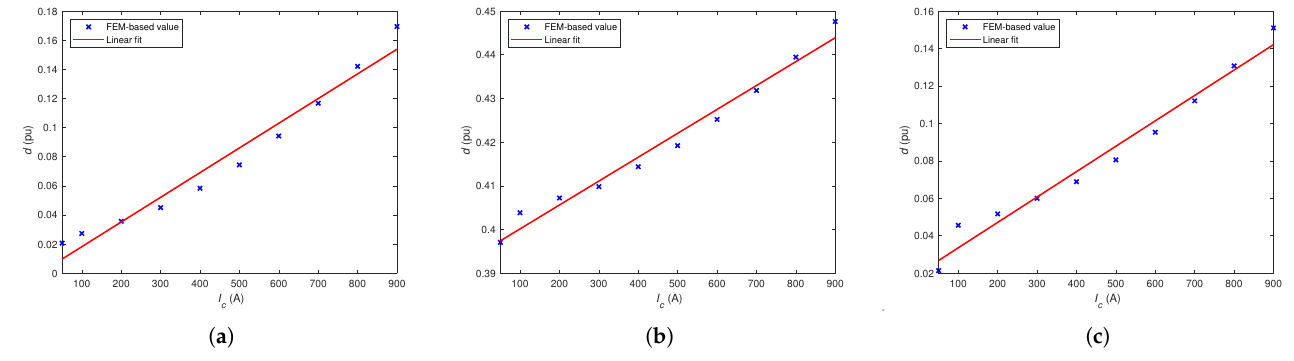
Figure 16. Estimation results for parameter d ( a ) Cable 1E; ( b ) Cable 2R; ( c ) Cable